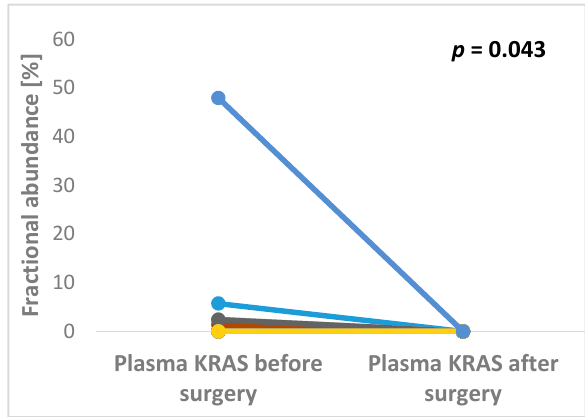
Figure 1. Significant changes in KRAS fractional abundance between pre- and post-operative plasma samples in patients undergoing surgery for colorectal cancer liver metastases ( p = 0.043).